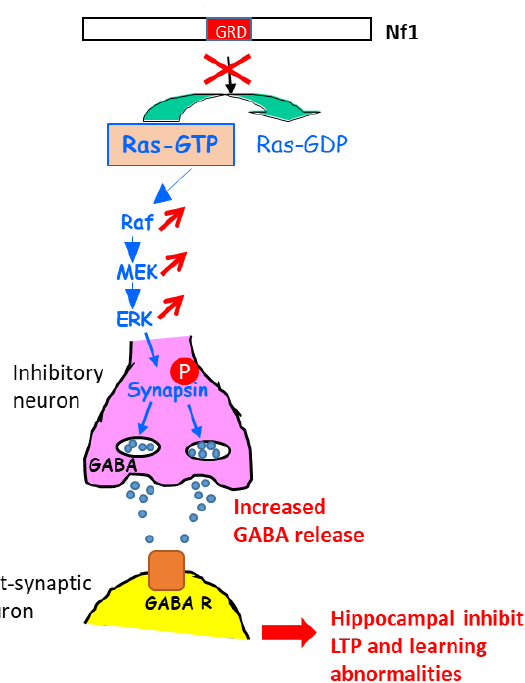
Figure 8. Schematic representation explaining the increase in GABA secretion upon the activation of ERK in NF1 -deficient inhibitory neurons. GABA R: GABA receptor.